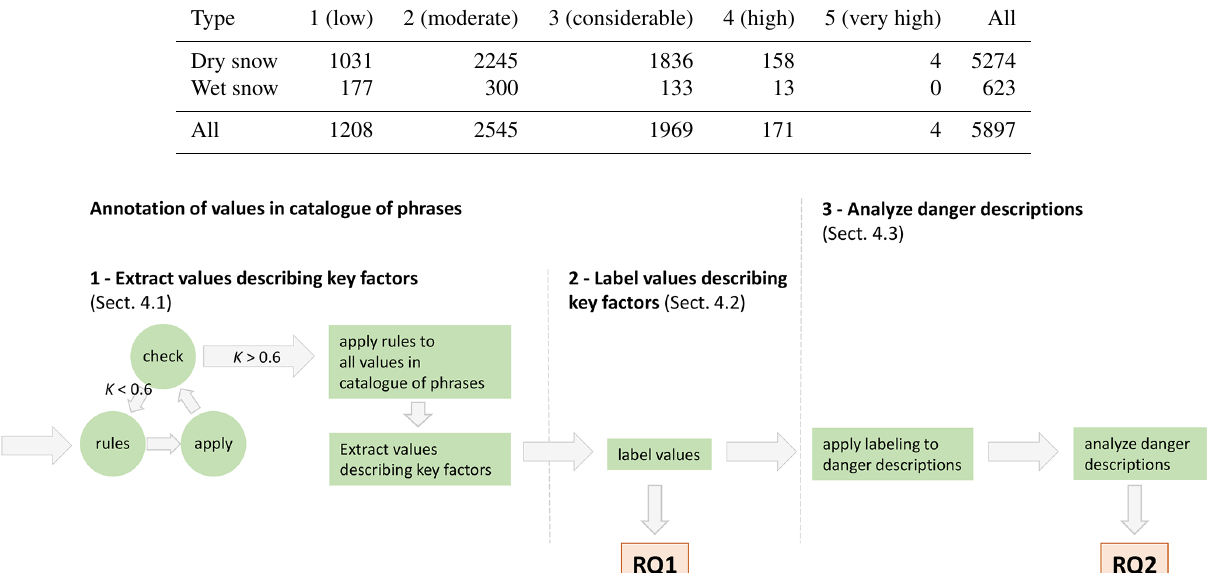
Figure 3. Workflow describing the annotation of values in the catalogue of phrases and the analysis of the danger descriptions. The annotation (step 1) and labeling (step 2) of the values allowed research question 1 to be answered (RQ1: how well do forecasters agree on the meaning of terms characterizing triggers required to release avalanches, frequencies of triggering spots, and expected avalanche sizes?), while the application of the labeling to the danger descriptions (step 3) permitted RQ2 to be answered (RQ2: how does the use of language in